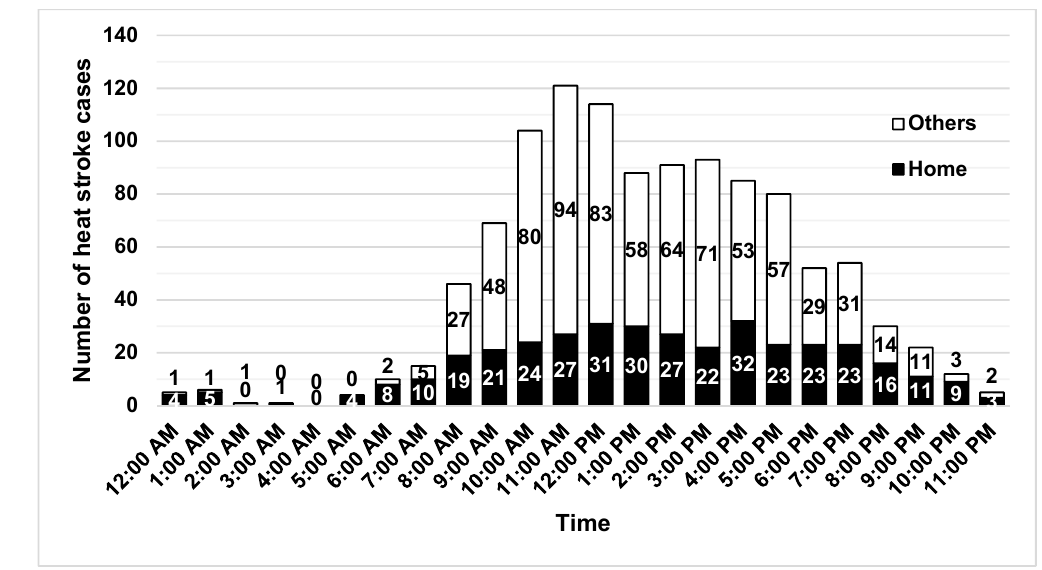
Figure 2. Pickup time for heat stroke cases. Black bars indicate the number of pickups at home and white bars indicate the others.